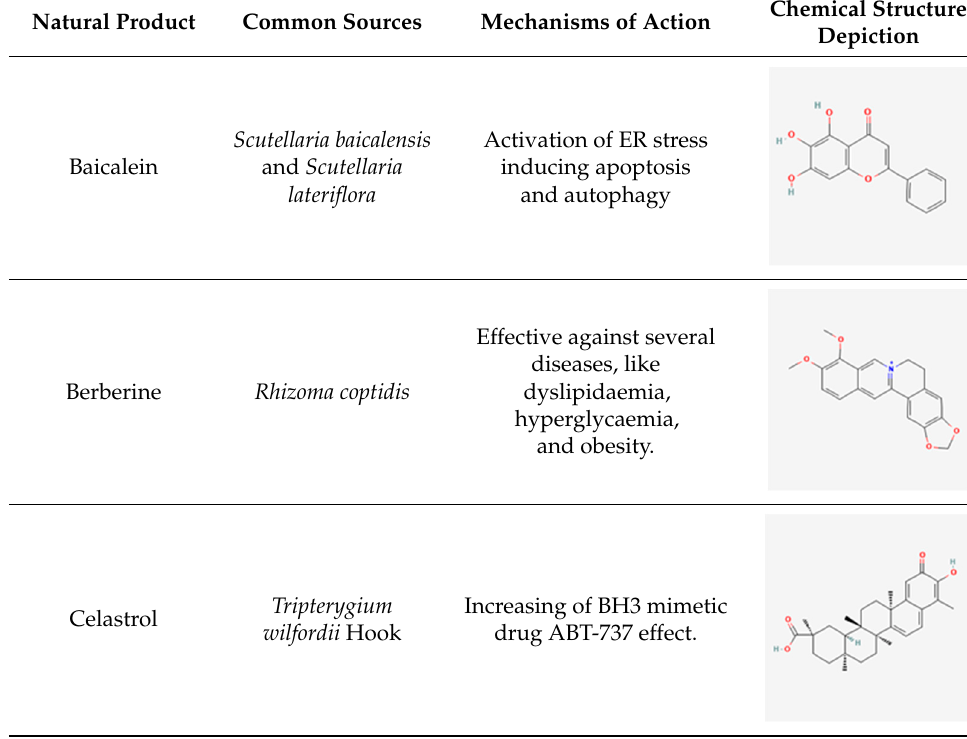
Chemical Structure Depiction